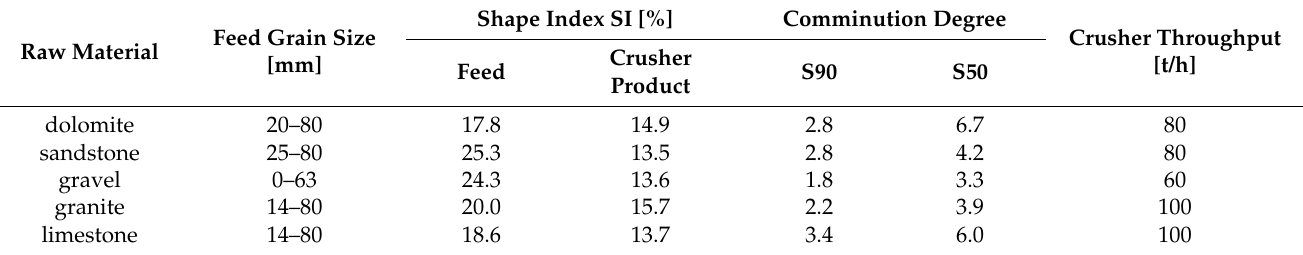
Table 4. Characteristics of raw materials and operation of the